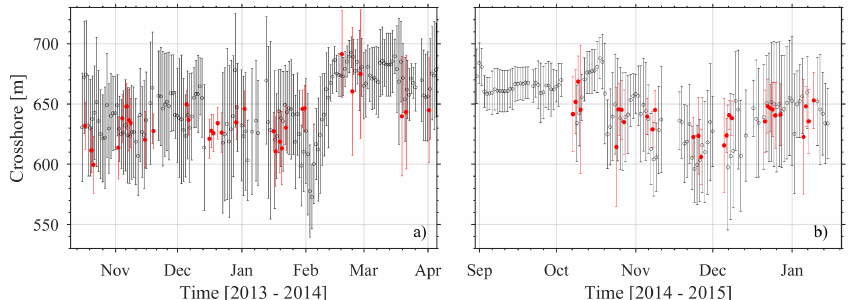
Figure 7. Longshore average bar position (dots) and standard deviation (bars) obtained from pixel intensities (red) and video-derived bathymetries (black) over time. Note that shore is at the bottom of the plots, offshore at the